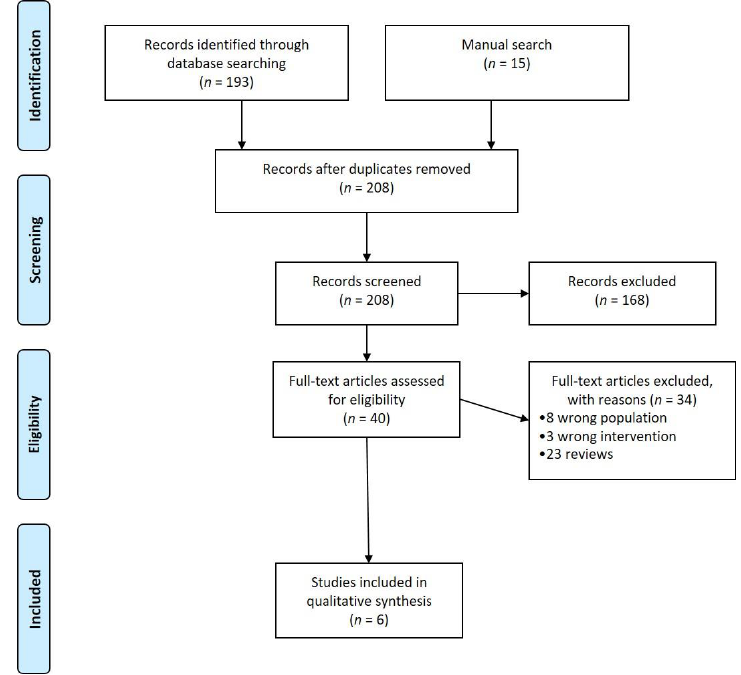
Figure 1. Preferred Reporting Items for Systematic Reviews and Meta-analyses (PRISMA) diagram.